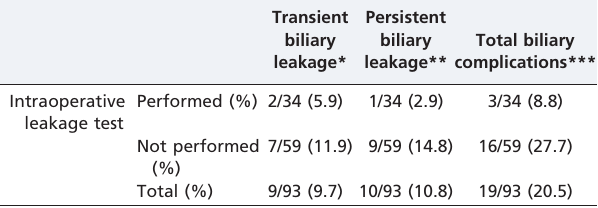
Table II - Results from both groups of